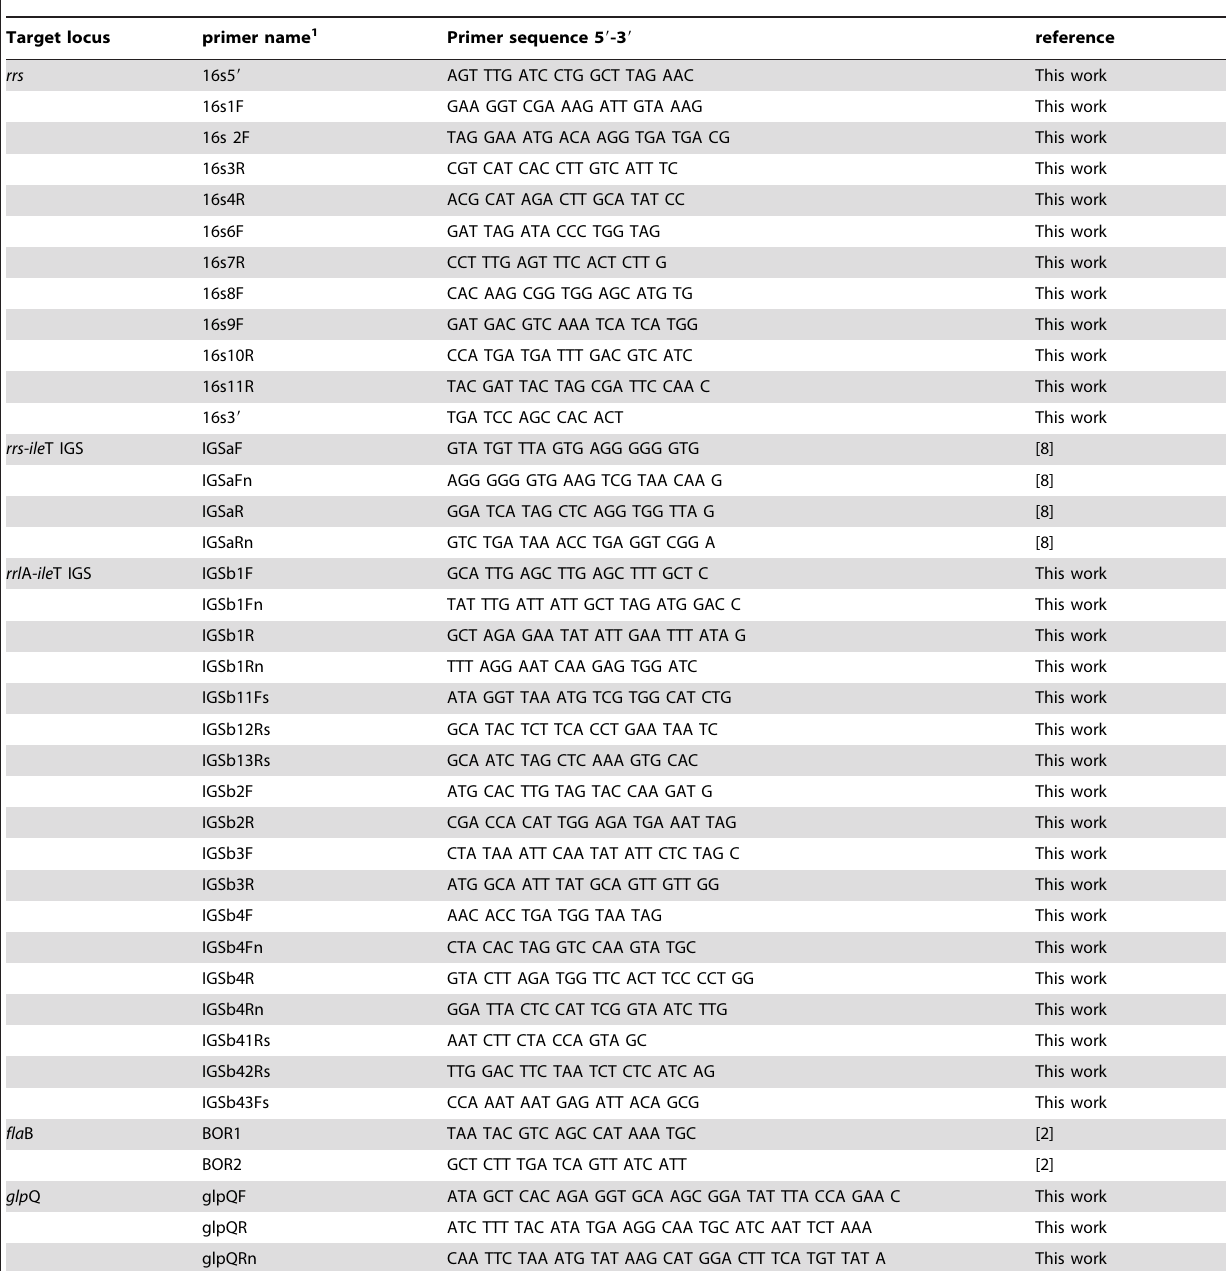
Table 2. List of the primers used in this